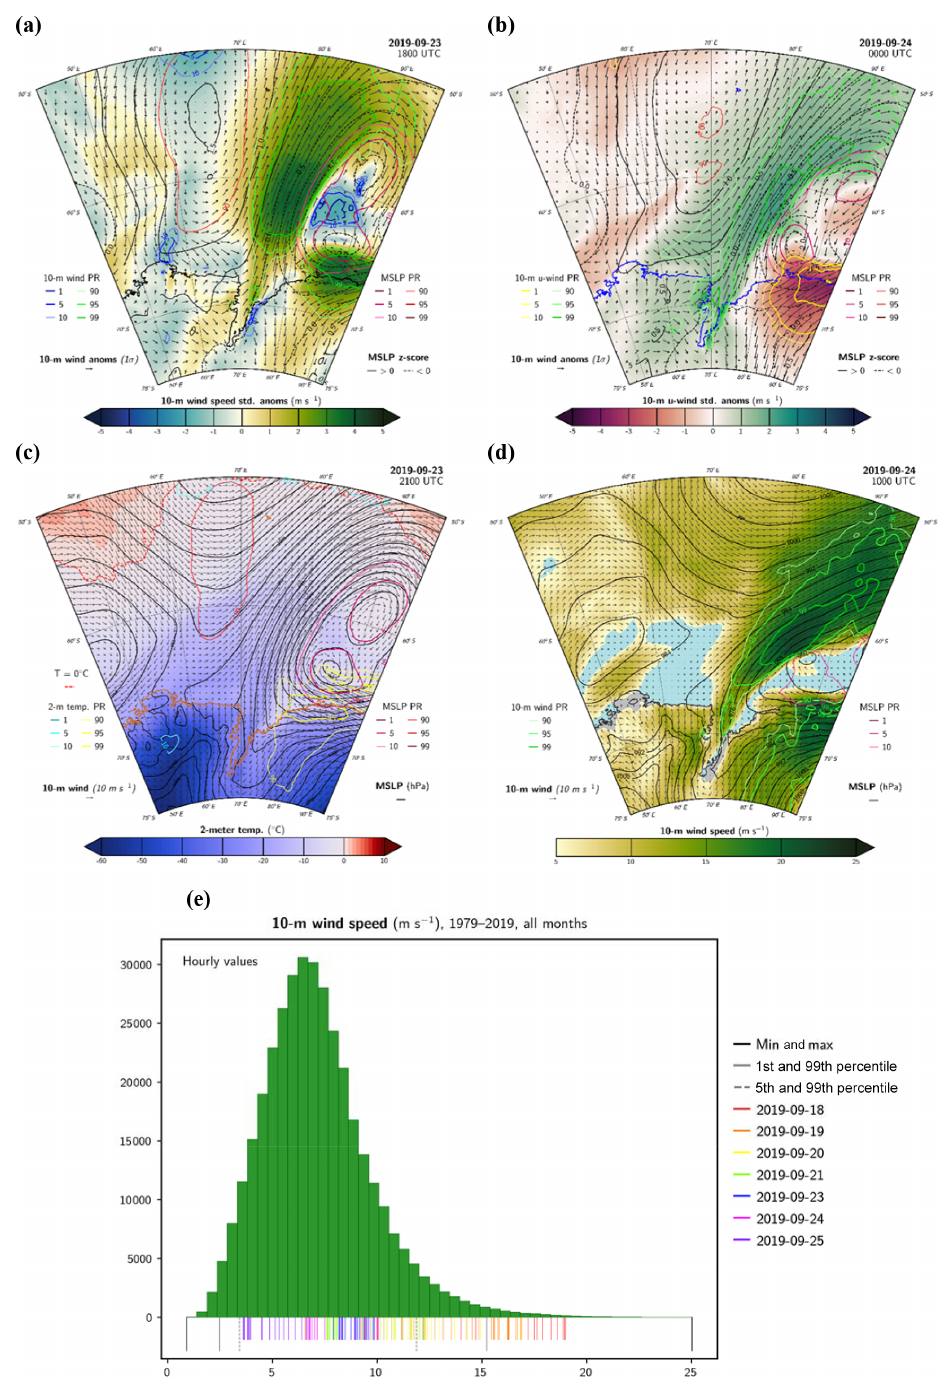
Figure 6. (a) Standardized anomalies (std. anoms) relative to the full September record (1979–2019) of 10m wind speed (colors) on 23 September 2019 at 18:00UTC. (b) Same as (a) but with the u component of 10m wind as filled contours on 24 September 2019 at 00:00UTC. Vectors show 10m wind anomalies; black contours show positive MSLP anomalies; and dashed black contours show negative MSLP anomalies. Colored contour lines show percentile rank (PR) extremes (1st, 5th and 10th as well as 90th, 95th and 99th percentile ranks) of the corresponding quantities indicated on the plots. (c) Temperature at 2m in colors, with winds at 925hPa in vectors, MSLP in black contours and 0 ◦ C contour on a red dashed line on 23 September at 21:00UTC. (d) Wind speed at 10m in colors, with 10m wind direction in black vectors and MSLP in black contours on 24 September 2019 at 10:00UTC. (e) Histogram showing the distribution of hourly 10m wind speed for all months during 1979–2019, spatially averaged over 70–65 ◦ S and 70–75 ◦ E. The colored vertical lines correspond to hourly values during the 18–25 September 2019 period. Each given day in September 2019 has 24 hourly values plotted in the same color. Please note that the date format used in this figure is year month day